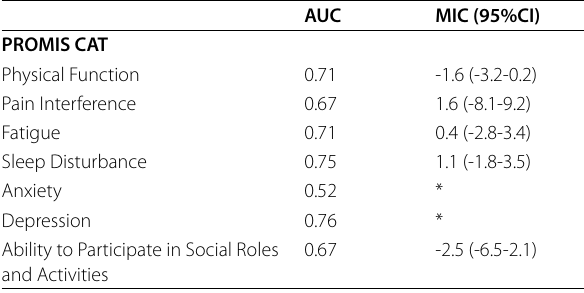
Ability to Participate in Social Roles and